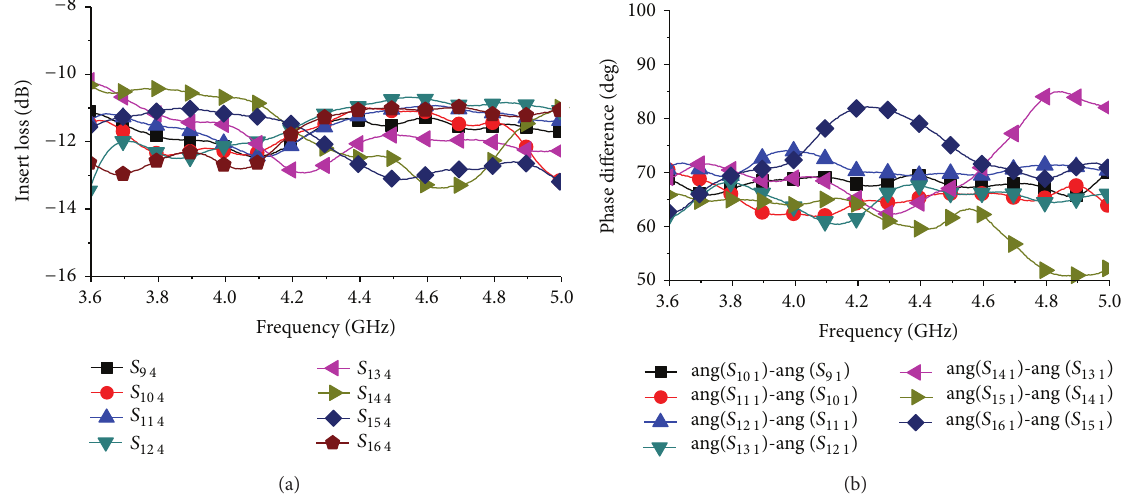
Figure 12: The measured results of insertion loss (a) and phase difference (b) at Port 4. The phase difference at Port 2 is 67.5 ∘